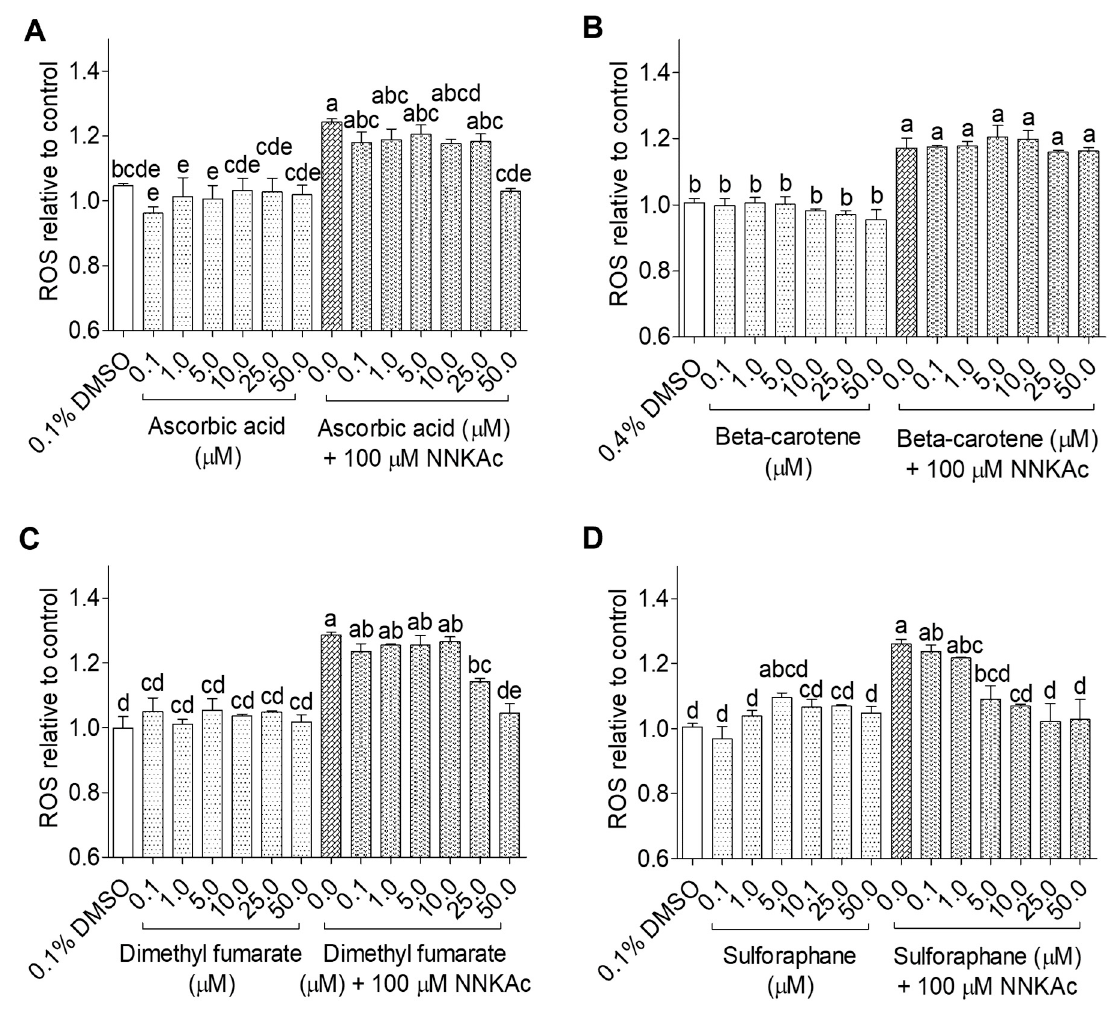
Figure 5. Effect of ascorbic acid ( A ), beta-carotene ( B ), dimethyl fumarate ( C ), and sulforaphane ( D ) on reducing NNKAc-induced ROS in BEAS-2B cells. Cells were pre-treated with concentrations ranging from 0.1 to 50 µ M of selected non-phenolic compounds for 3 h. Pre-treated cells were exposed to 100 µ M NNKAc for another 3 h to induce ROS generation. DMSO (0.1% or 0.4%) was used as the vehicle control. Effects on ROS levels were quantified using DCFDA fluorescence assay. Two independent studies ( n = 3) were performed, and results were expressed as mean ± standard deviation. Statistical analysis of data was performed by one-way ANOVA and mean comparison was done by Tukey’s mean comparison method ( α = 0.05) using Minitab 19 statistical software (LLC, Pennsylvania, USA). Mean values that do not share similar letters in bar graphs are significantly different ( p < 0.05). Abbreviations: NNKAc: 4-[(Acetoxymethyl)nitrosamino]-1-(3-pyridyl)-1-butanone, DCFDA: 2 ′ 7 ′ -dichlorofluorescein diacetate, ROS: reactive oxygen species, DMSO: dimethyl sulfoxide.